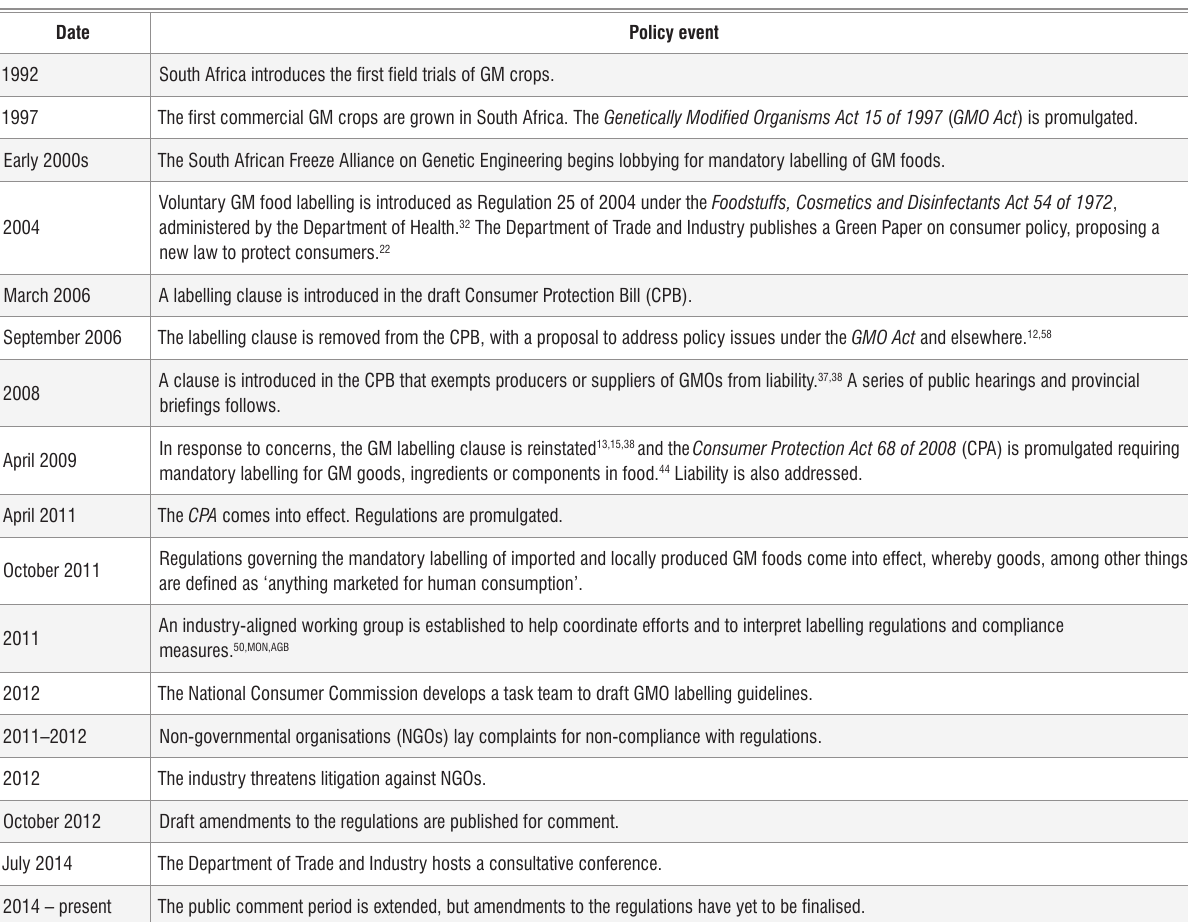
Chronology of significant events and decisions during the policy development and implementation of mandatory GM food labelling in South